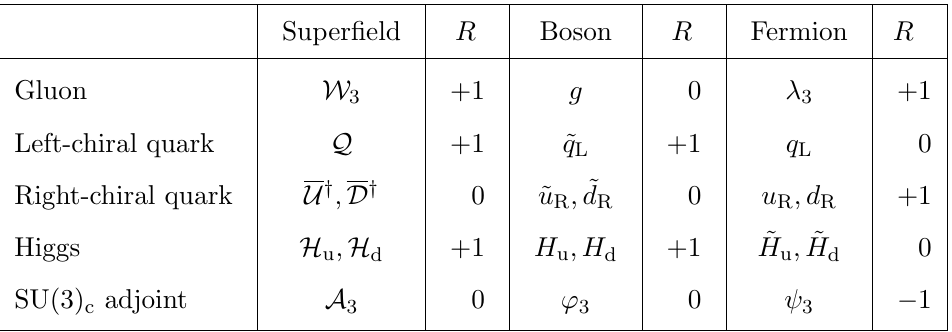
Table 1. R charges of selected (cid:12)elds in a minimal model with R symmetry broken only by a B (cid:22)